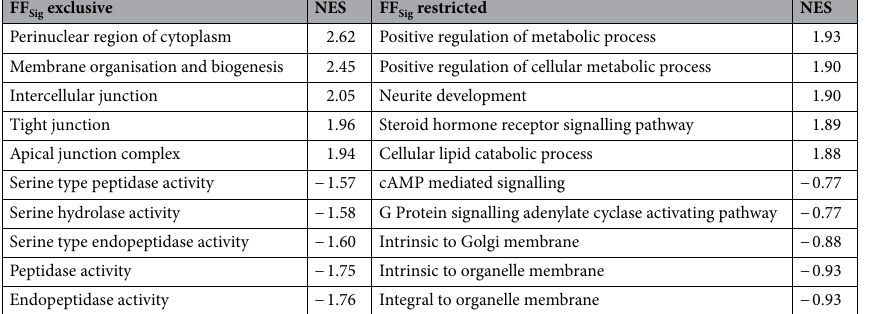
Table 6. The GO terms that have the highest NES and exclusively RRs with FF Sig (left) and the GO terms that are restricted to have RRs with FF Sig (right), experimented on the NRG-S